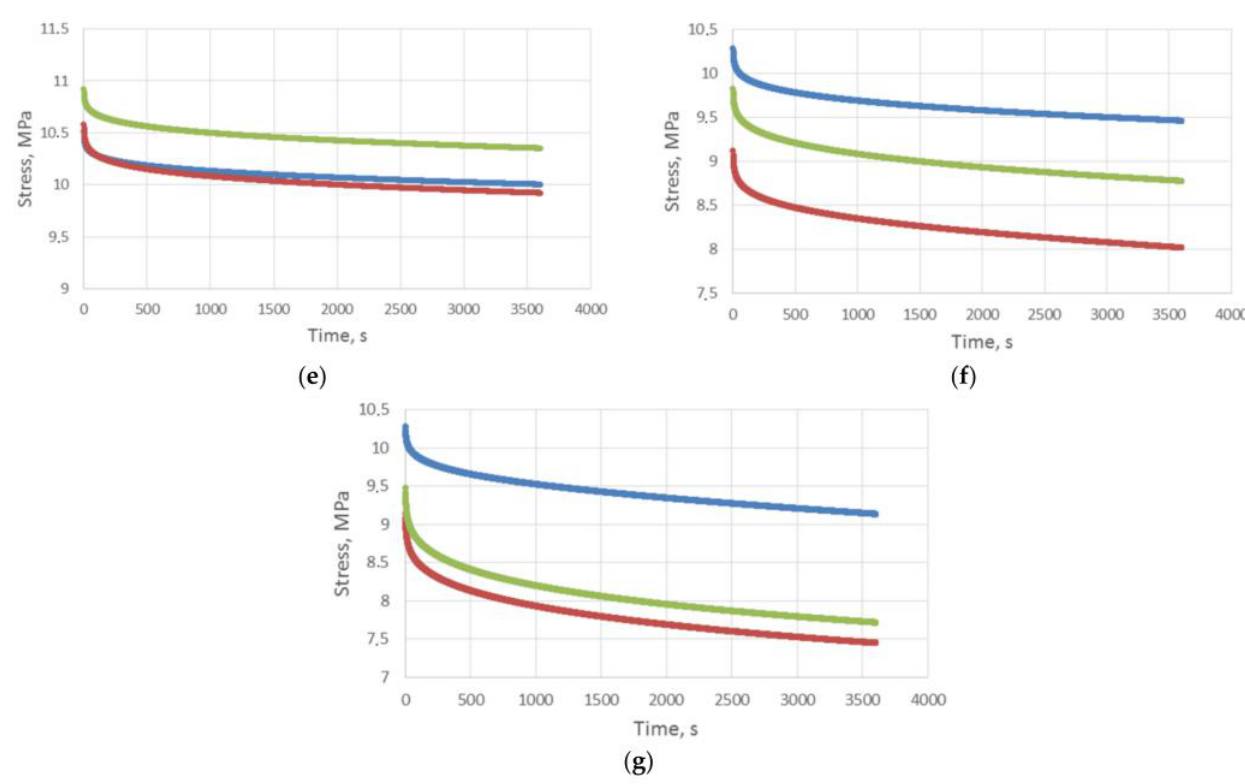
Figure 4. Relaxation characteristics of test specimens, ( a ) samples—A, ( b ) samples—B, ( c ) samples—C, ( d ) sampes—D, ( e ) samples—E, ( f ) samples—F, ( g ) samples—G.